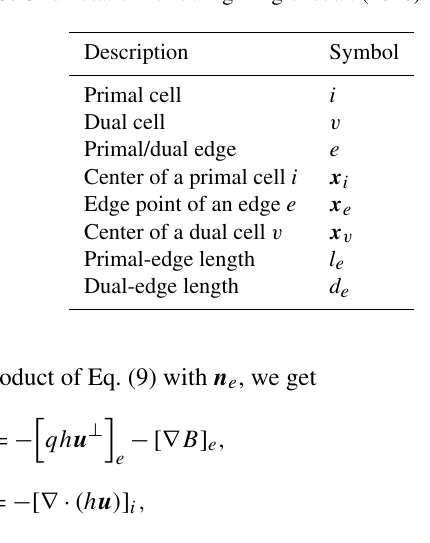
Table 3. Grid notation following Ringler et al.